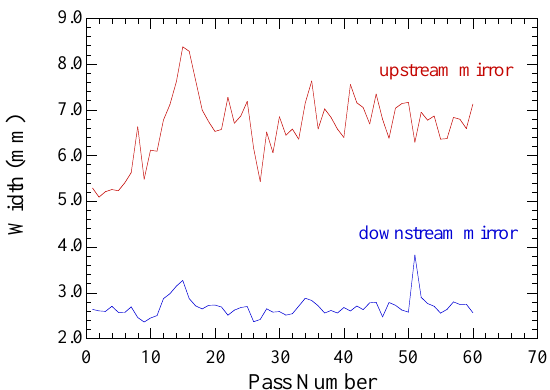
Figure 16. Variation in the width (rms diameter) of the optical beam incident on the upstream mirror (red) and downstream mirror (blue) as a function of the number of passes for a cavity detuning of ∆ L cav = − 8 λ and an undulator field strength of B u = 6.658 kG ( K rms = 1.055). The other parameters are given in Table